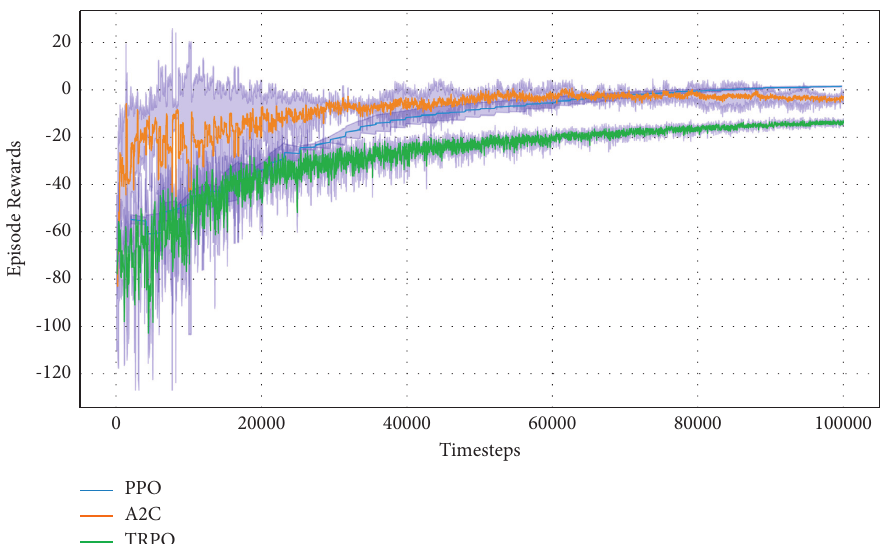
Figure 8: Learning curves for the fighter-jammer scenario. The shaded region represents the standard deviation of average evaluation over three trails.